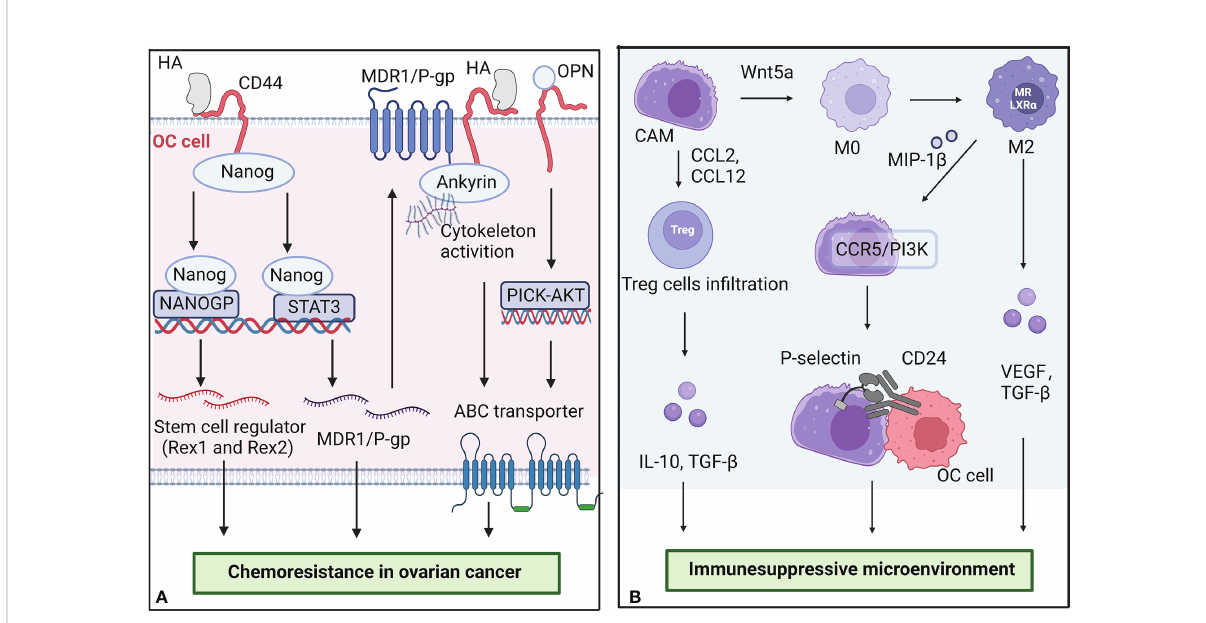
FIGURE 2 The role of CAMs in chemoresistance and the formation of immunesuppressive microenvironment. (A) CAMs secret HA and OPN to promote the chemoresistance of OC cells. The binding of HA to CD44-Nanog complex activated the expression of Nanog-special target genes Rex1 and Sox2. Some activated Nanog interacted with STAT3 to upregulate the expression of multidrug resistance-1 (MDR1) gene. OPN activated HA/CD44/PI3K- AKT signaling pathway to promote the expression of ABC transporter proteins. (B) CAMs interact with other cells in the microenvironment to promote the formation of immunesuppressive microenvironment in OC. CAMs can secrete Wnt5a to regulate macrophage polarization and increase T regulatory cell in fi ltration. M2 macrophages promote the adhesion of CAMs and OC cells by overexpressing MIP-1 b . The fi gure was created with